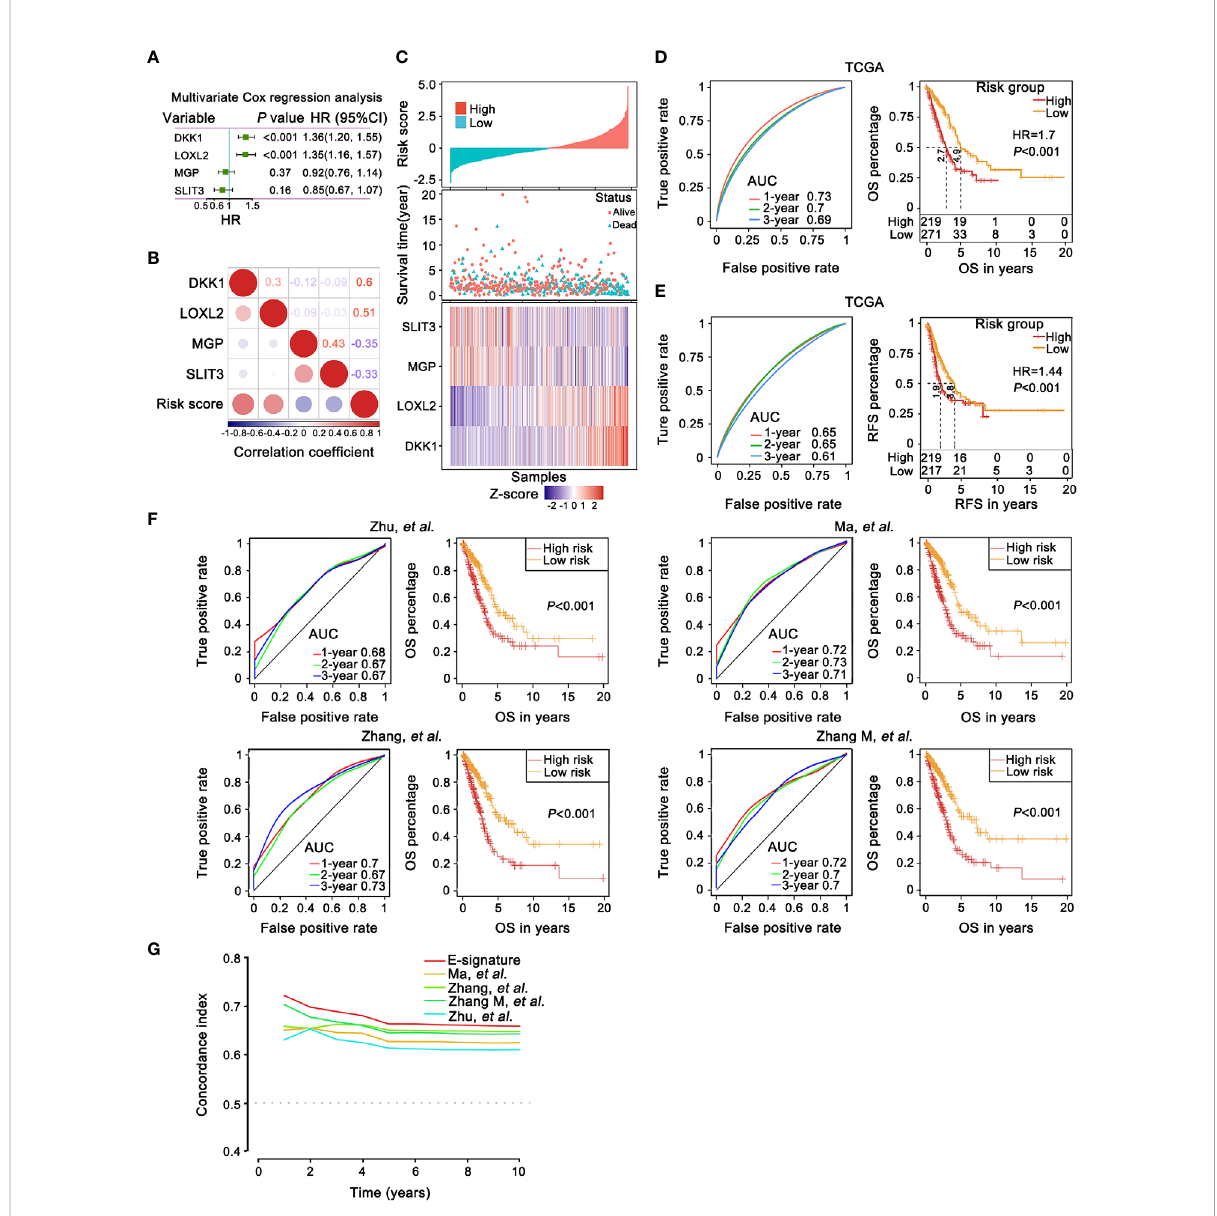
FIGURE 4 The prognostic robustness and clinical usefulness of the E-signature in the internal training set. (A) Evaluating the impact of 4 EMT-related genes on OS by means of forest plot. (B) Relatedness plot reported Pearson correlation values of each comparison. The bar color indicated Pearson corr. Values below the map calculated between risk score and genes in the matrix. (C) The risk score, survival time and status of each sample in TCGA-LUAD cohorts. The heatmap listed expression status of each gene involved in the signature. (D, E) The time-dependent receiver operating characteristic (ROC) curves for the 1-, 2- and 3-year OS (D) and relapse free survival (RFS) prediction (E) by the E-signature. Signi fi cant survival difference between high- and low-threshold group. (F) A comparison with previously reported E-signature models by KM survival analysis and ROC curve. (G) The E-signature had the highest concordance index (C-index) as opposed to other reported models, which proved that it could accurately predict